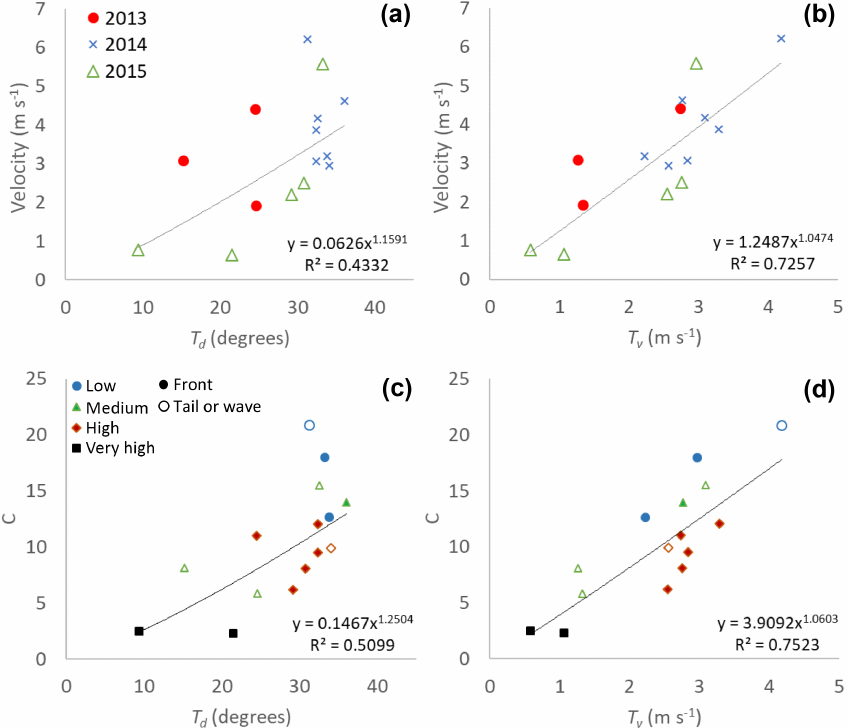
Figure 9. LSPIV average surge velocity (classified by events) are compared to (a) the directional turbulence index ( T d ) and (b) the velocity turbulence index ( T v ). The flow resistance coefficient ( C ; Eq. 1; classified by visually estimated sediment concentrations) is compared to (c) T d and (d) T v (from Table